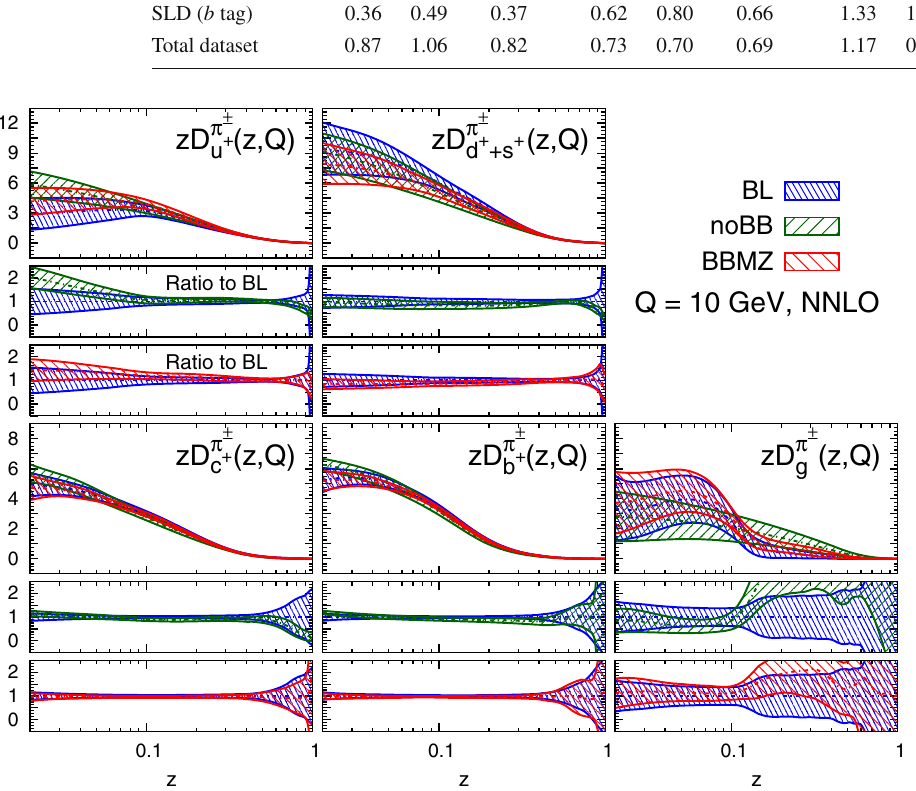
Fig. 20 Comparison among the NNFF1.0 NNLO FFs for charged pions for three variations of the fitted dataset: BL , noBB and BBMZ (see the text for details). The bands indicate their one- σ uncertainties. The ratios of the noBB and BBMZ fits to the BL fit are displayed in the lower